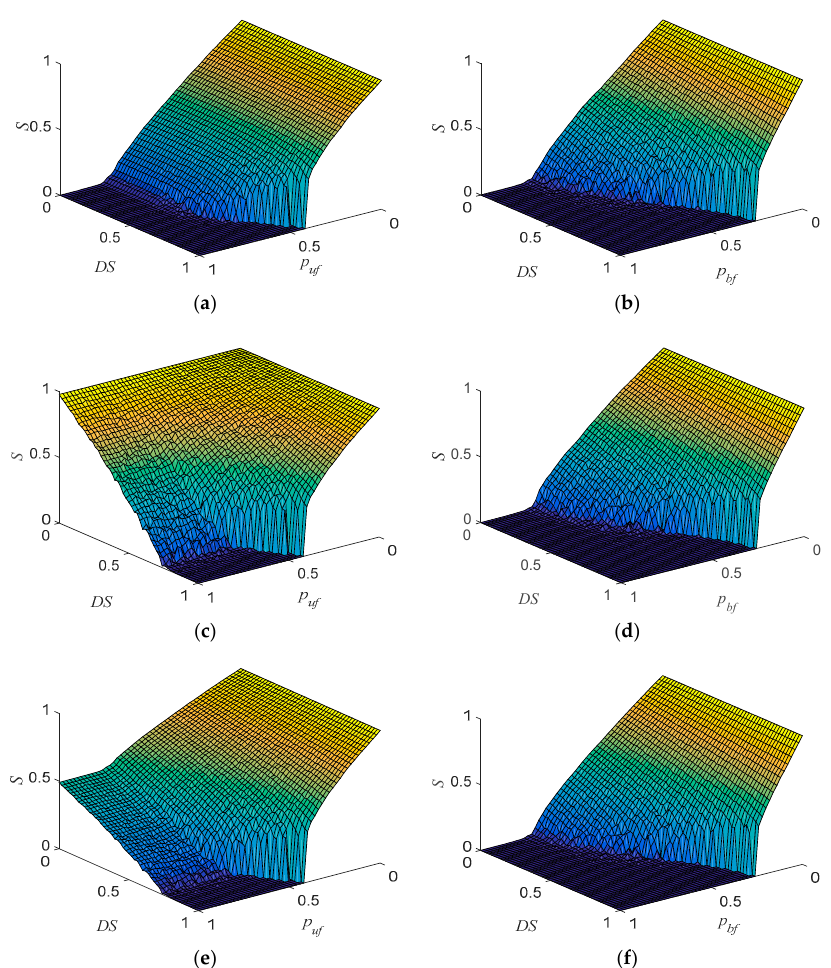
Figure 7. The cascading failure of subnetwork A, subnetwork B, and the entire interdependent networks with different dependency strength ( DS ) under unilateral failure (UF) and bilateral failure (BF), results of one simulation. ( a ) cascading failure of subnetwork A with different DS under UF; ( b ) cascading failure of subnetwork A with different DS under BF; ( c ) cascading failure of subnetwork B with different DS under UF; ( d ) cascading failure of subnetwork B with different DS under BF; ( e ) cascading failure of the entire interdependent networks with different DS under UF; ( f ) cascading failure of the entire interdependent networks with different DS under BF;.